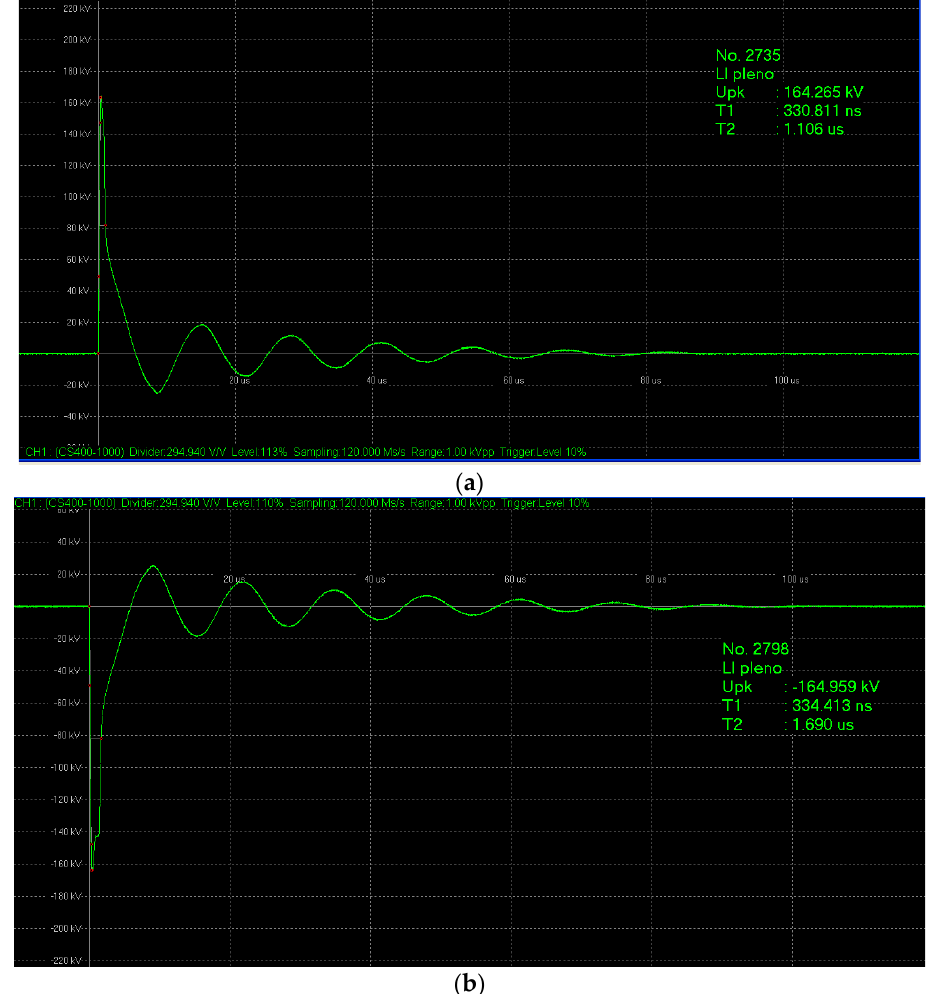
Figure 7. Wave shapes after impulse discharge on dunite sample: ( a ) positive polarity; ( b ) negative polarity.